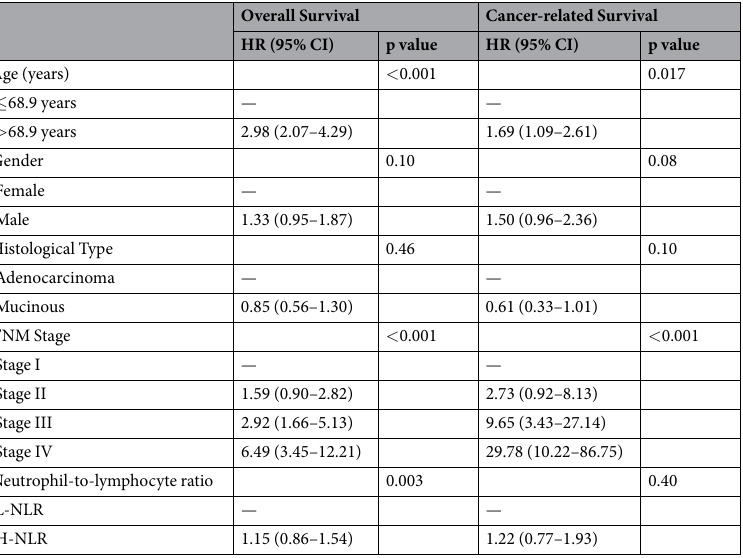
Table 4. Multivariable survival analysis including neutrophil-to-lymphocyte ratio (NLR) for the 603 patients under study. a Values in parentheses are 95% confidence intervals. Hazard ratio and p values were derived from Cox regression analysis, controlling for all other variables.